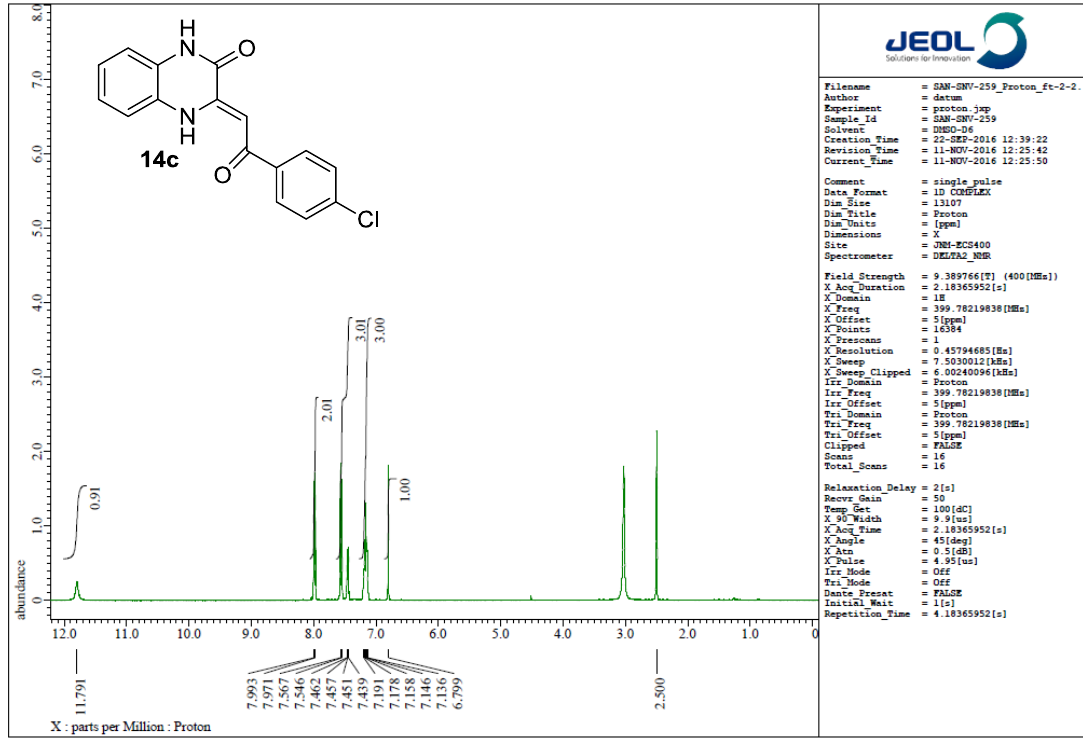
Figure 33 . 1 H NMR Spectra of Compound 14c .